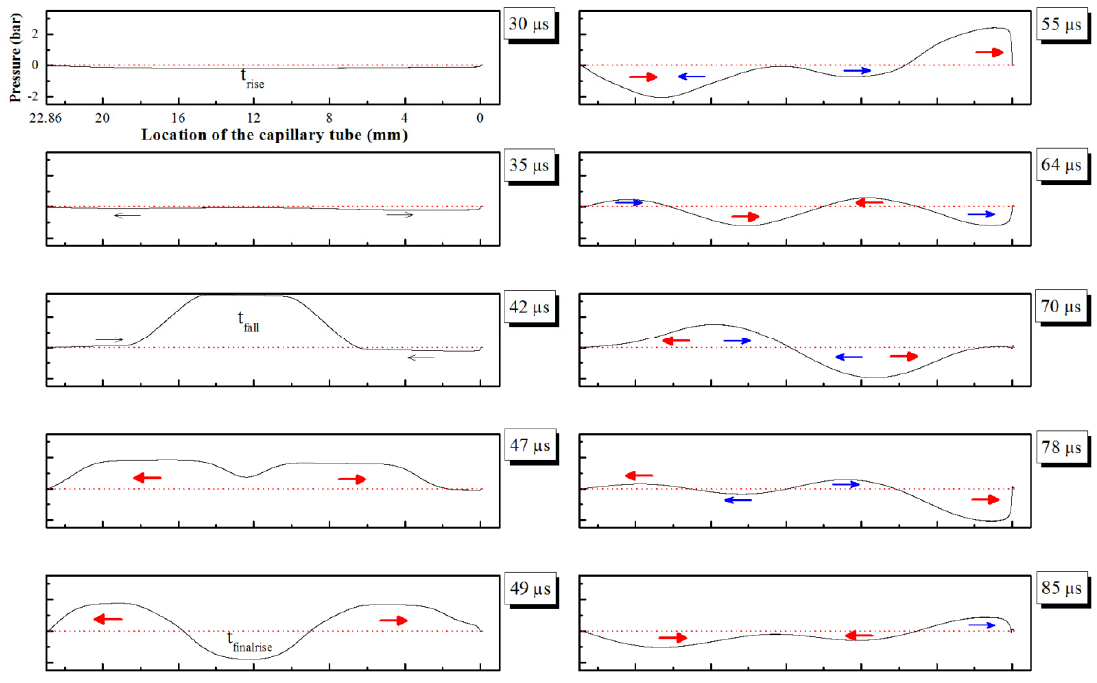
Figure 4. Pressure distributions versus time induced with bipolar waveform along capillary tube. Dispenser orifice is located at 0 mm and reservoir is located at 22.86 mm. Pressure propagation and reflection are denoted by black arrow for t rise , red arrow for t fall , and blue arrow for t finalrise .